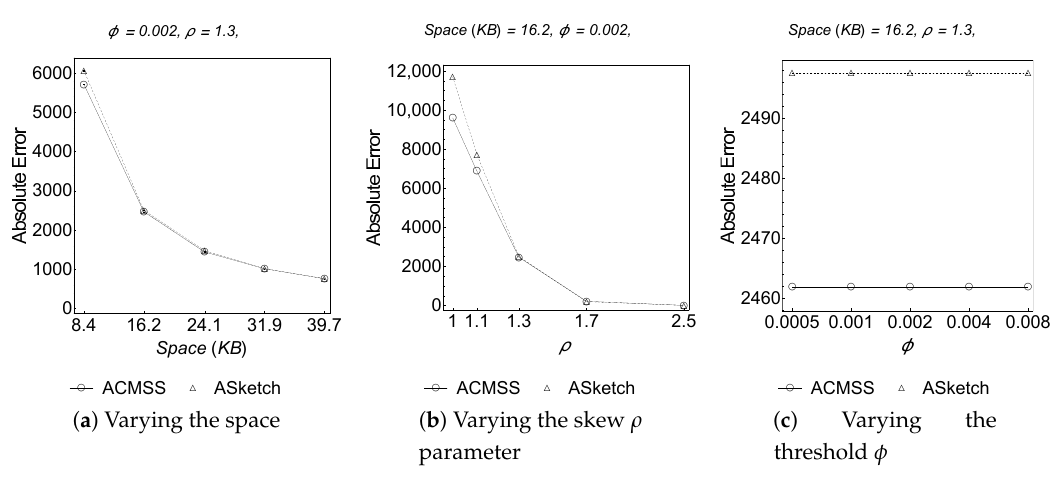
Figure 2. Accuracy of the algorithms: Average Absolute Error. Table 3. Absolute Error (average and maximum), zipfian distribution with skew ρ = 1.3 and support threshold φ = 0.002.